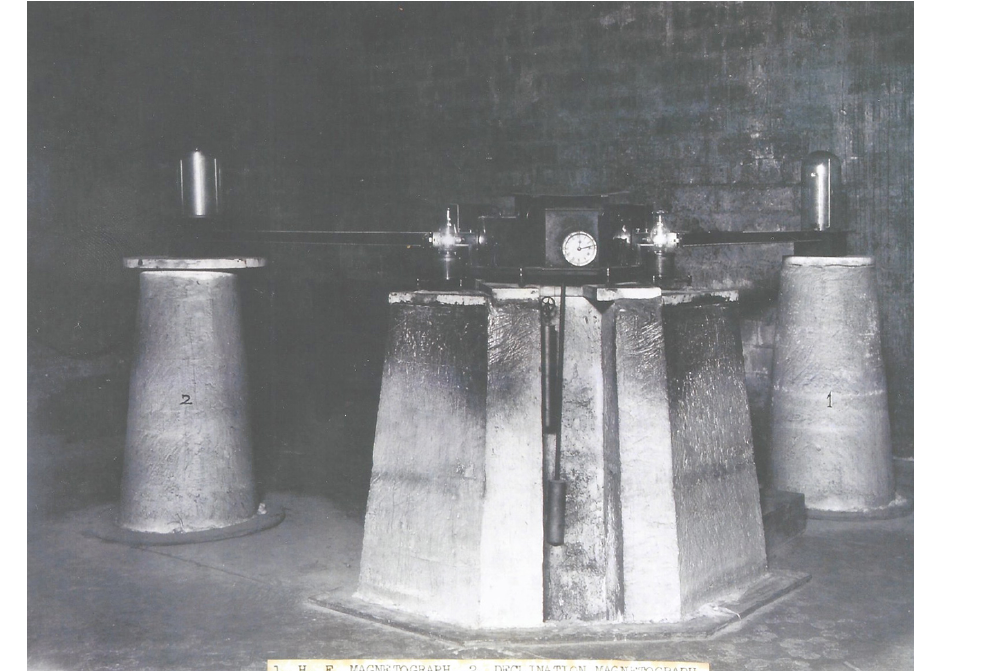
Figure 13. Arrangement of pillars and magnetometers that existed at Alibag. The pillars were meant for sensors. The H magnetometer was placed on top of the pillar marked 1 (extreme right). The D magnetograph was kept on pillar 2 (extreme left). The center pillar had a clock and bulb for deflection and vibration experiments. Recording drums were installed on separate pillars. The recording drum had a chain and weight arrangement (courtesy of Colaba–Alibag